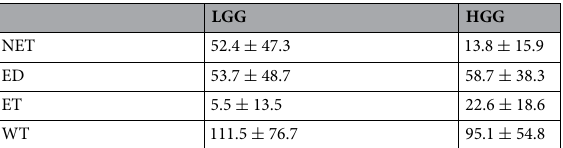
Table 1. Comparison of voxel volumes (mean ± standard deviation) [ cm between LGG and HGG in the validation dataset (MICCAI_BraTS_Training). NET: necrotic and non- enhancing tumor core, ED: peritumoral edema, ET: Gd-enhanced tumor, WT: whole tumor (= NET + ED +